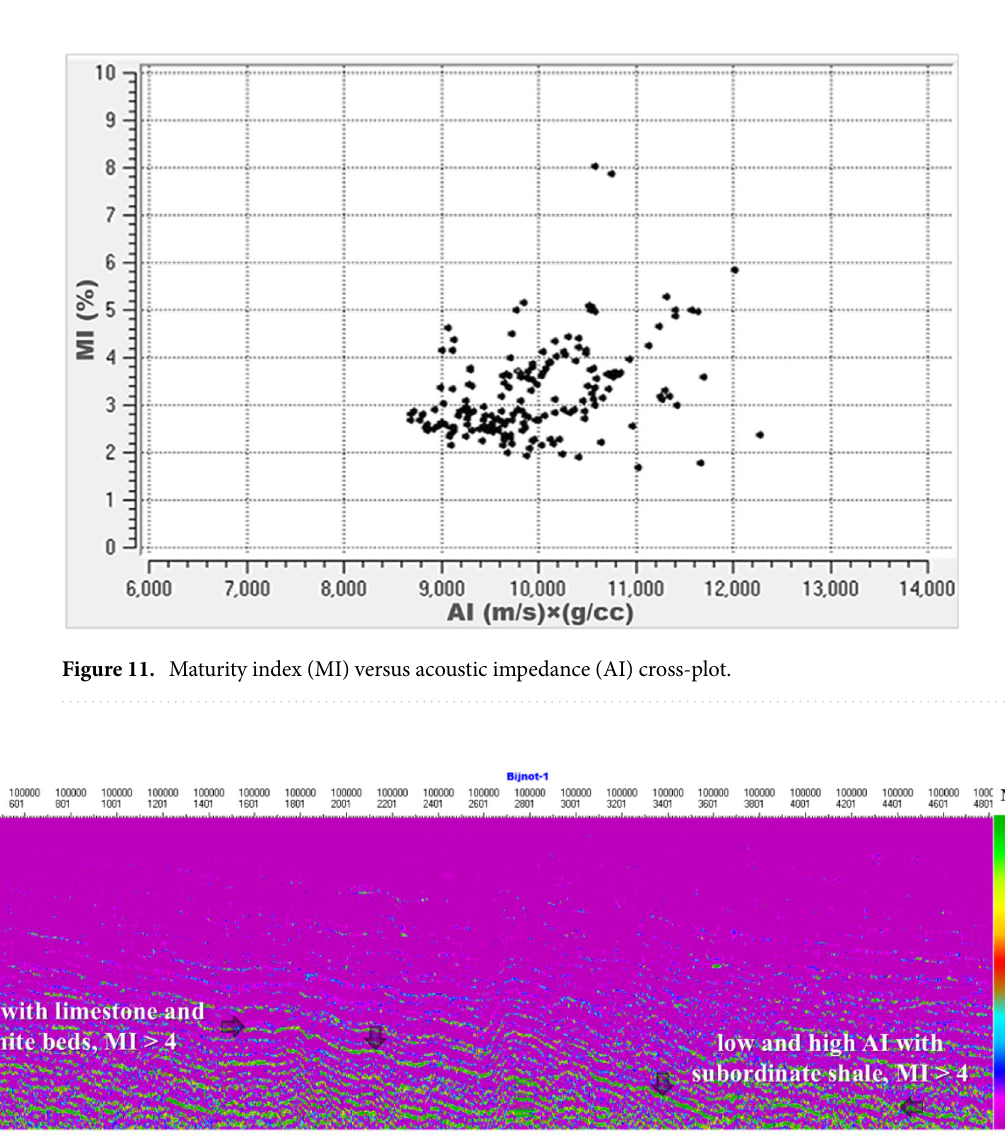
Figure 12. Seismic inverted MI profile using the MLC and PSO inversion strategy in Cambrian and Infracambrian rock sequences at 1100–1500